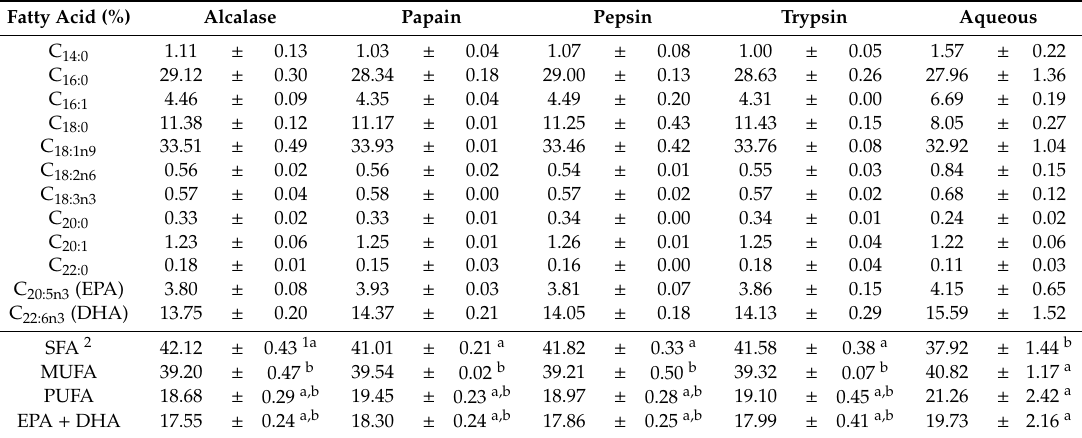
1 All values represent the mean of three replicates ± standard deviation. Values with di ff erent superscript letters within a row significantly di ff er ( p < 0.05). 2 SFA = Saturated fatty acids, MUFA = Monounsaturated fatty acids, PUFA = Polyunsaturated fatty